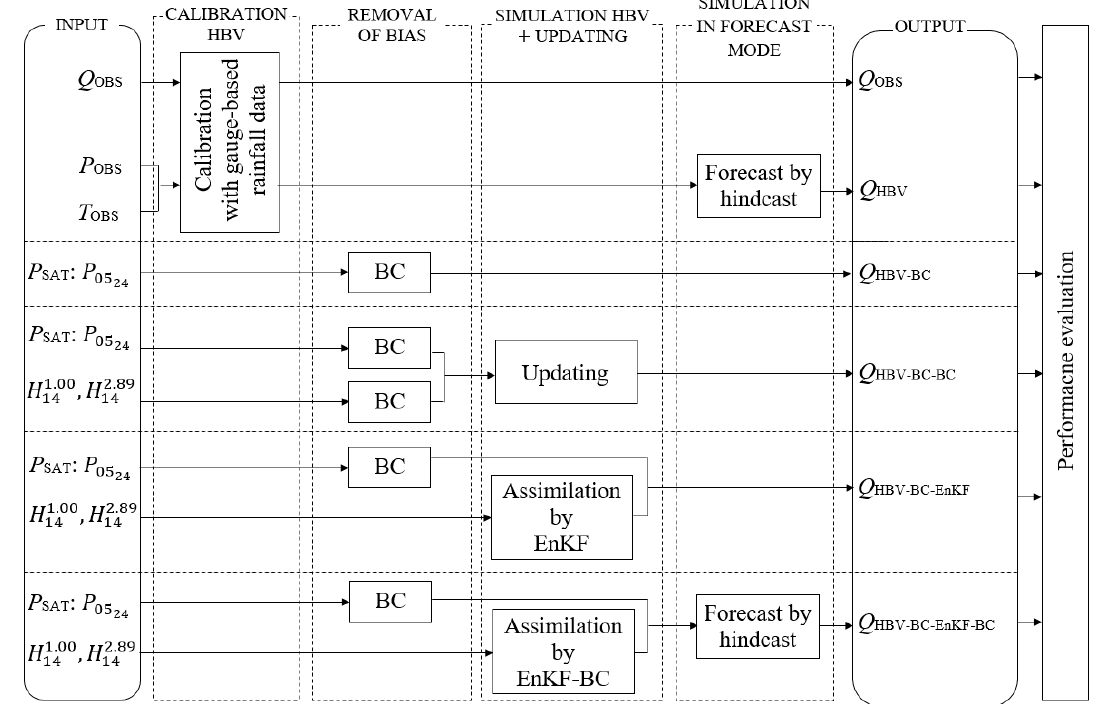
Figure 2. The block diagram of the methodology, where P OBS , T OBS and Q OBS represent mean ground-based precipitation, temperature and river discharge, respectively. P SAT represents the P 05 24 and H 14 , H 1.00 and H 2.89 represent soil moisture observations; Q HBV is the product of the HBV model without correction and assimilation procedures; Q HBV − BC represents the product of the HBV model with bias-corrected satellite precipitation and without assimilation; Q HBV − BC − BC is the product of the HBV model with bias-corrected satellite precipitation and with bias-corrected satellite soil moisture data without assimilation; Q HBV − BC − EnKF is the product of the HBV model with bias-corrected satellite precipitation and with assimilation of the satellite soil moisture (EnKF); and Q HBV − BC − EnKF − BC represents the product of the HBV model with bias-corrected satellite precipitation and with assimilation of the satellite soil moisture data with bias correction of the perturbed soil moisture for the creation of an unbiased ensemble of model states (EnKF-BC).